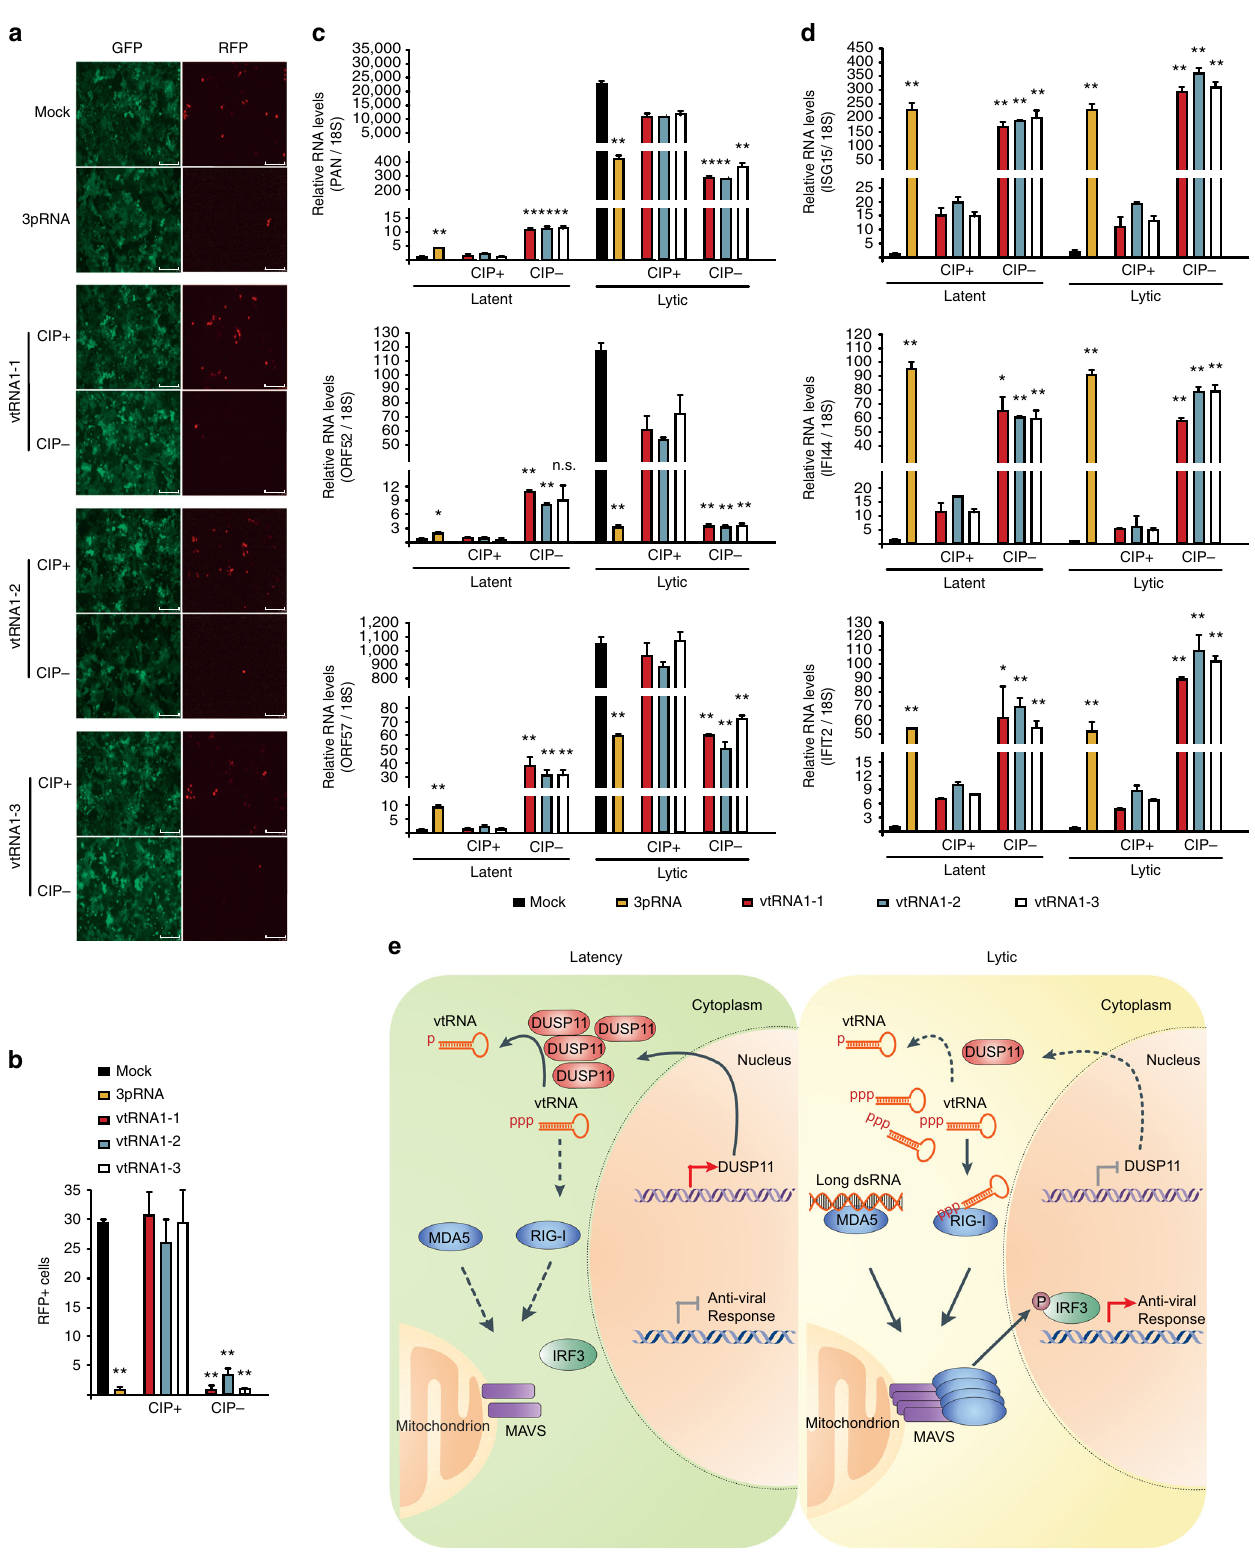
recognition of RNA by RIG-I in the context of KSHV reactivation is likely the result of multiple mechanisms, and dependent on the precise molecular steps involved in the biogenesis of a given RNA, with a de fi ciency in 5 ′ -end processing one potential